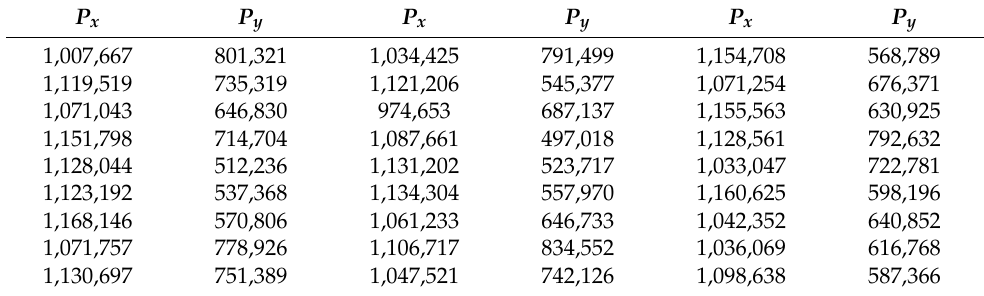
Table 1. Coordinates of points for instance